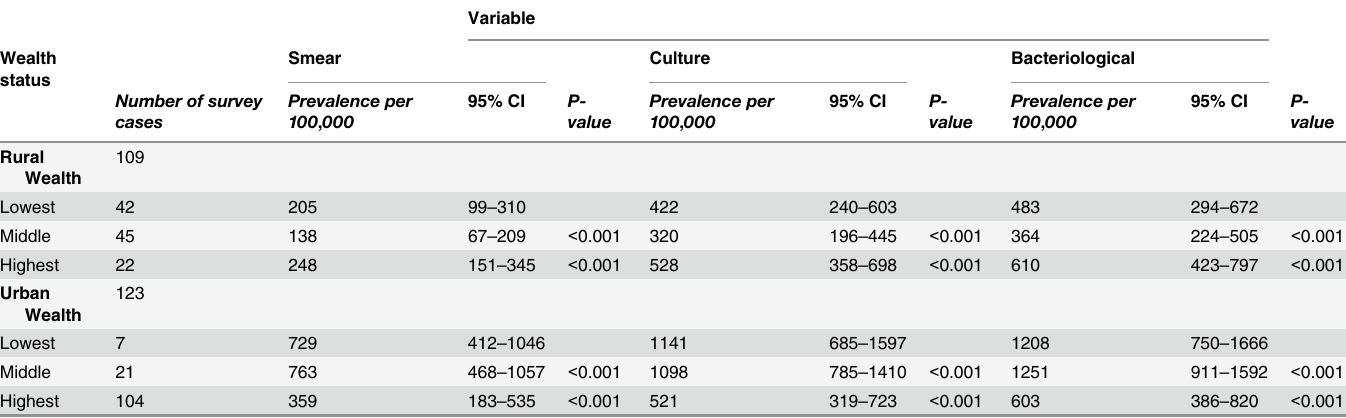
Table 4. TB prevalence by socioeconomic status for rural and